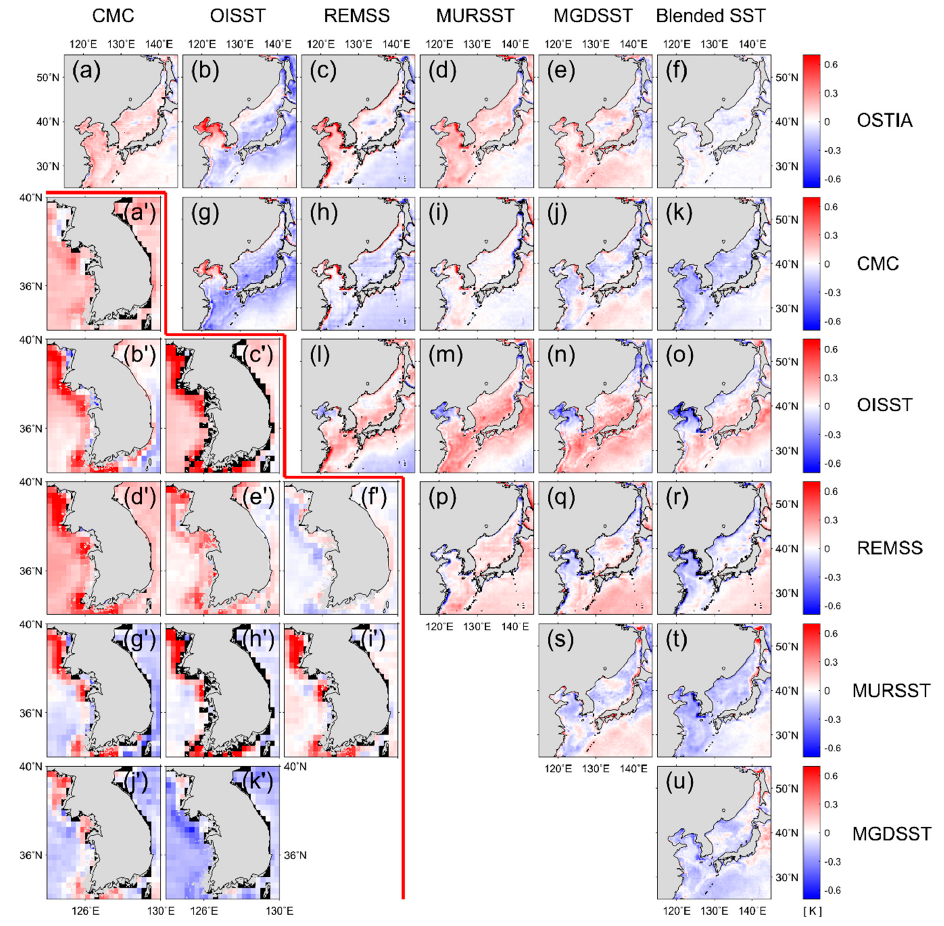
Figure 10. Spatial distribution of bias of ( a ) CMC analysis, ( b ) OISST, ( c ) REMSS analysis, ( d ) MURSST, ( e ) MGDSST, and ( f ) Blended SST for the OSTIA; ( g ) OISST, ( h ) REMSS analysis, ( i ) MURSST, ( j ) MGDSST, and ( k ) Blended SST for the CMC analysis; ( l ) REMSS analysis, ( m ) MURSST, ( n ) MGDSST, and ( o ) Blended SST for the OISST; ( p ) MURSST, ( q ) MGDSST, and ( r ) Blended SST for the REMSS analysis; ( s ) MGDSST and ( t ) Blended SST for the MURSST; and ( u ) Blended SST for the MGDSST. ( a’ – k’ ) are enlarged from ( a – k ), respectively.